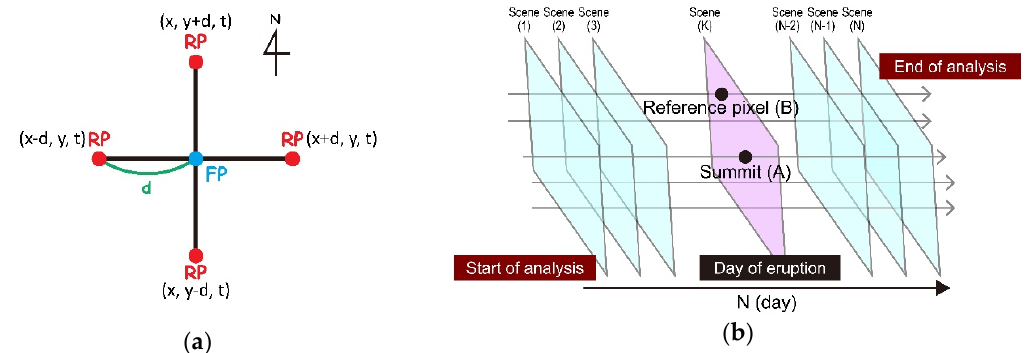
Figure 2. Schematic illustrations of the computation procedure in this study. ( a ) Relationship between a focal point and corresponding four reference points; ( b ) time–series analysis of scenes.